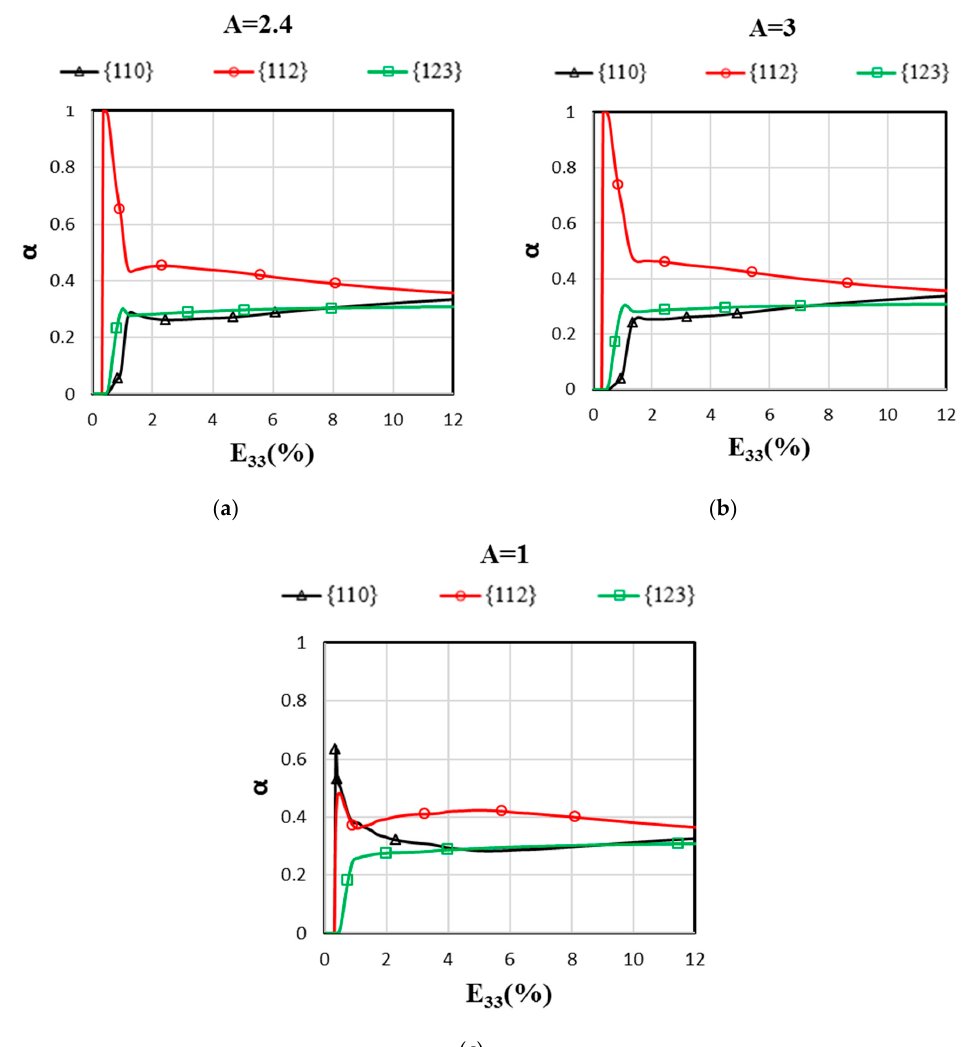
Figure 6. Relative slip plane family activities (dimensionless) as a function of the macroscopic strain predicted by the EVPSC model for A = 2.4 ( a ), 3 ( b ), and 1 ( c ). The applied tensile strain rate in the X 3 -direction is ε = 2 × 10 − 4 s − 1